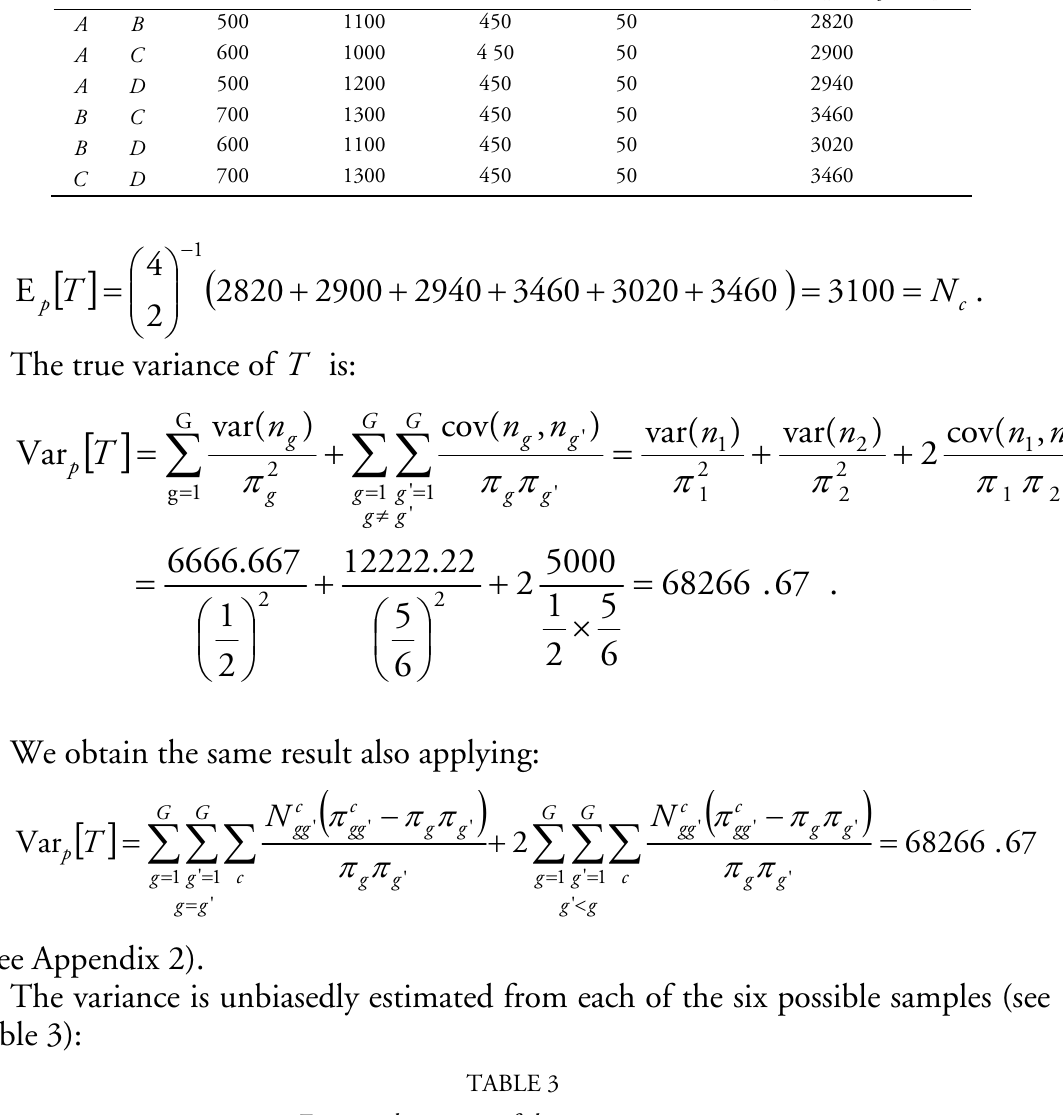
Estimated variance of the size estimator